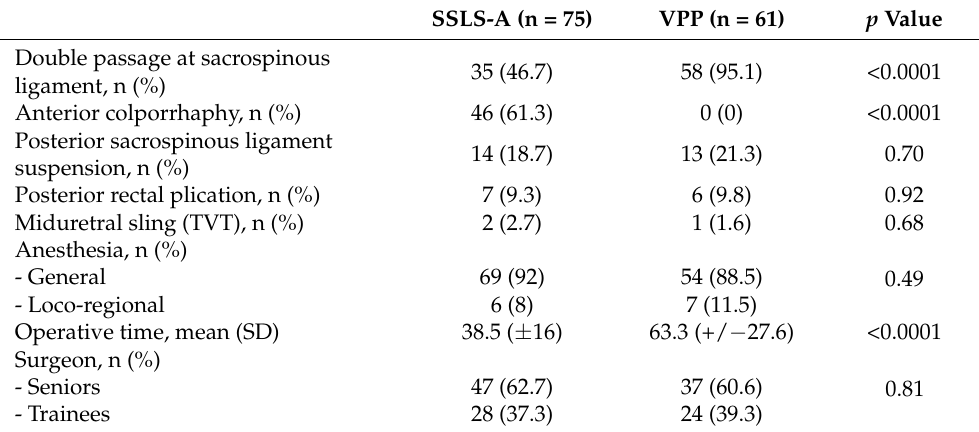
Table 4. Surgical procedures performed in the study population at time of pelvic surgery and intraoperative data.